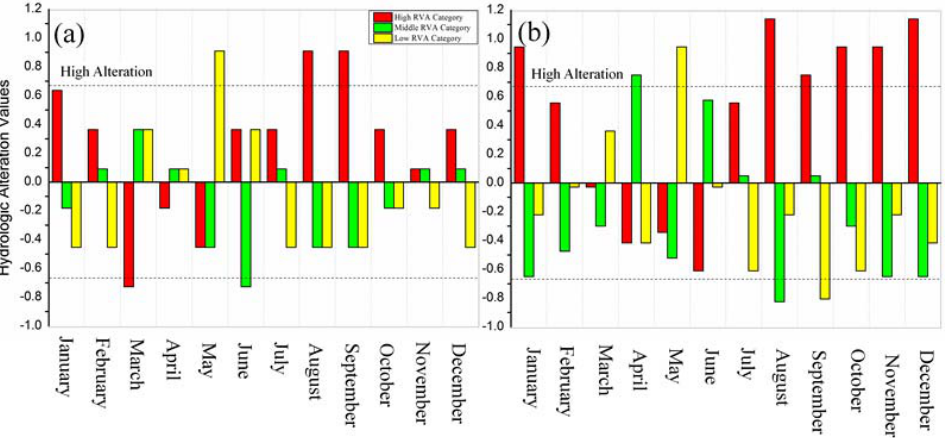
Figure 6. Hydrologic alteration of monthly streamflow in the JRW based on RVA method. ( a ): North River reach; ( b ) West River reach.